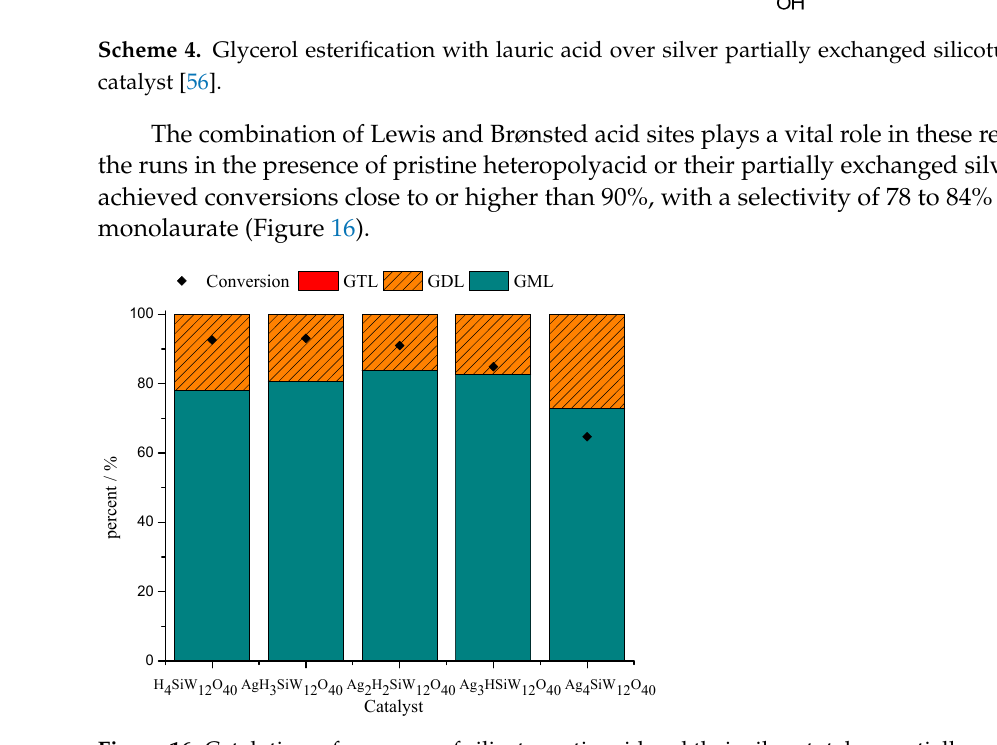
Figure 16. Catalytic performances of silicotungstic acid and their silver total or partially exchanged salts in the esterification of glycerol with lauric acid (adapted from ref. [56]). Reaction conditions: glycerol to the lauric acid molar ratio (4:1); amount of catalyst (4 wt.%); reaction time (150 min); reaction temperature (423 K).